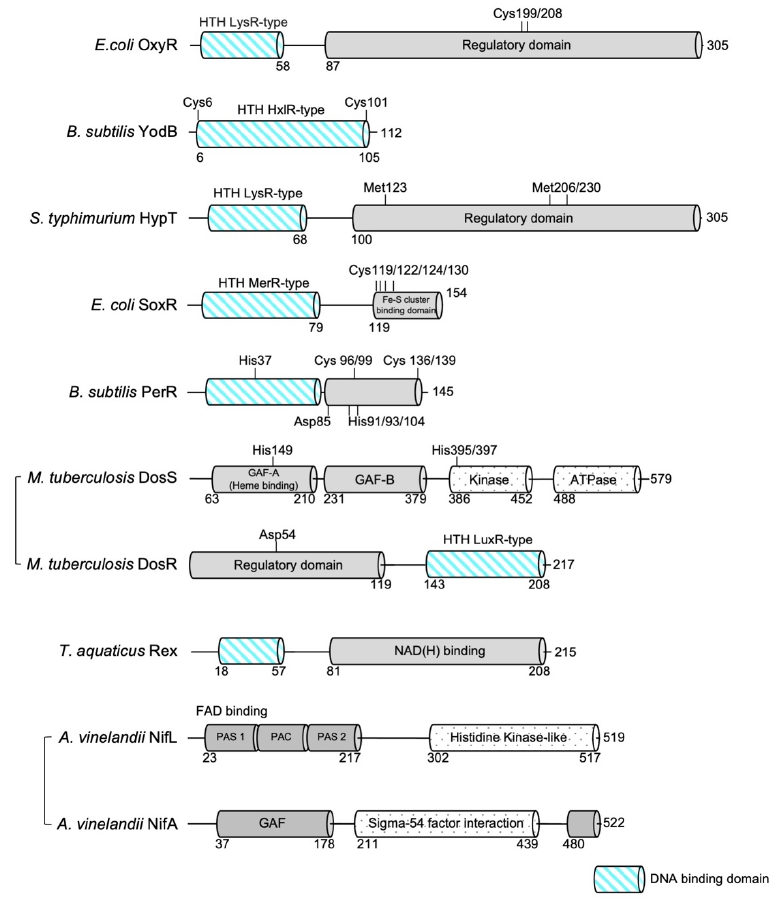
Figure 1. Domain organization of bacterial redox sensors highlighting the DNA-binding domain . Residues critical for redox sensing are marked. The diagrams of M. tuberculosis DosS and A. vinelandii NifL are not to scale with the other domain diagrams.